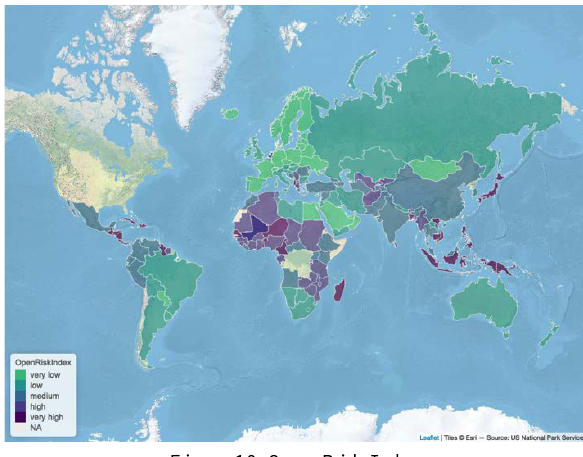
Figure 10. Open Risk Index Figure 10 the world risk to natural hazard. The classification is adopted from the World Risk Index by the quantile